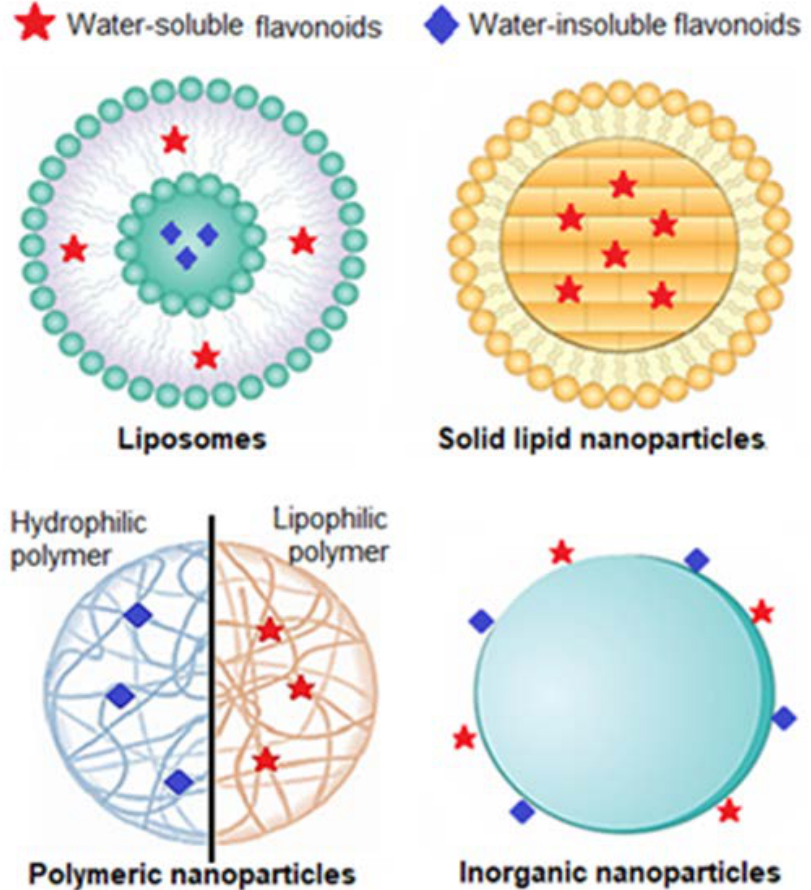
Figure 4. Types of nanoparticles mostly used for topical administration of UV filters on sunscreens Adapted from [103].